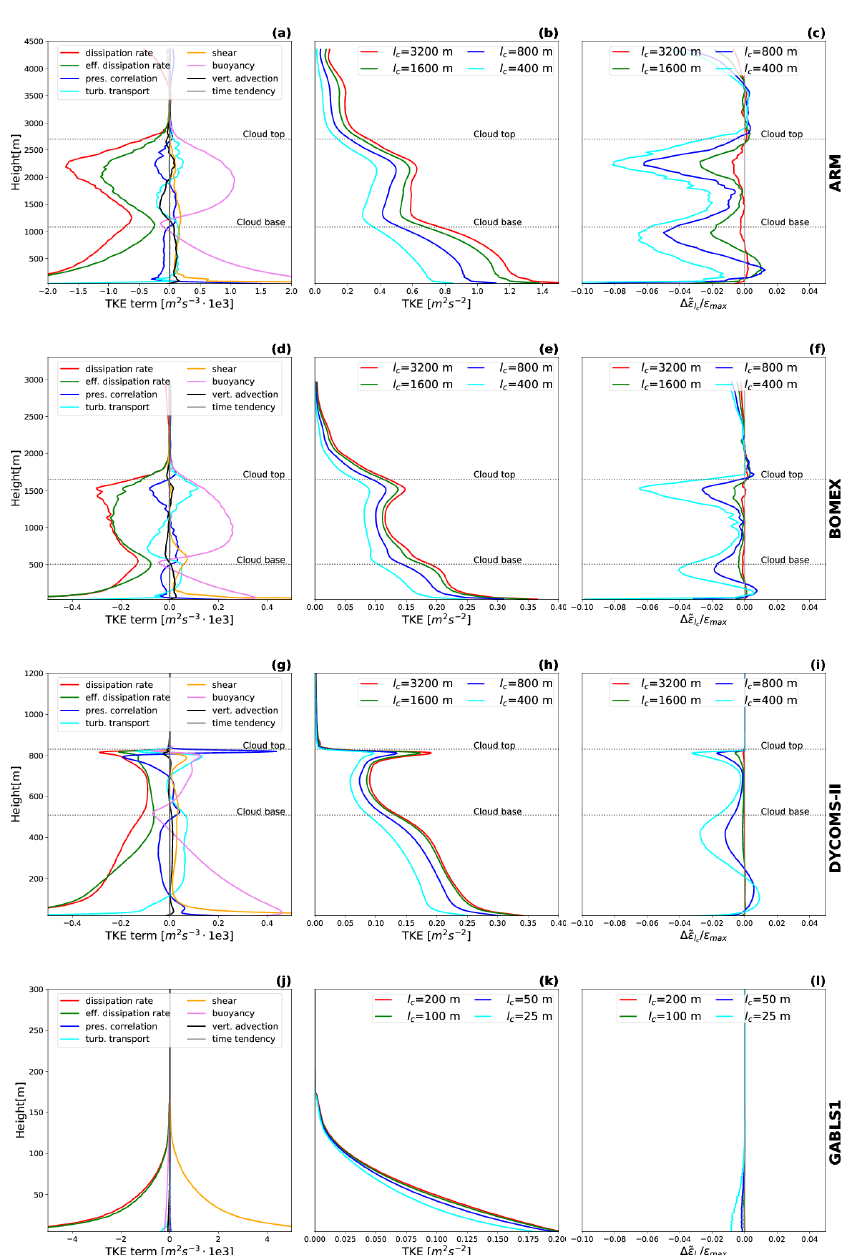
Figure 1. The TKE budget terms ( a , d , g , j ), the TKE ( b , e , h , k ) and the normalized differences in the effective dissipation rate, ∆ ˜ (cid:101) c ( l c ) / (cid:101) max = ( ˜ (cid:101) c ( l c ) − (cid:101) ) / max z ( (cid:101) ) , ( c , f , i , l ) for four cases: ARM (first row), BOMEX (second row), DYCOMS-II (third row), and GABLS1 (fourth row). The TKE budget terms are displayed for the smallest sub-domain size, where side of the sub-domain is equal to 1/32 of the side of the whole domain. The TKE and the differences in the effective dissipation rate are displayed for different sub-domain side sizes, l c